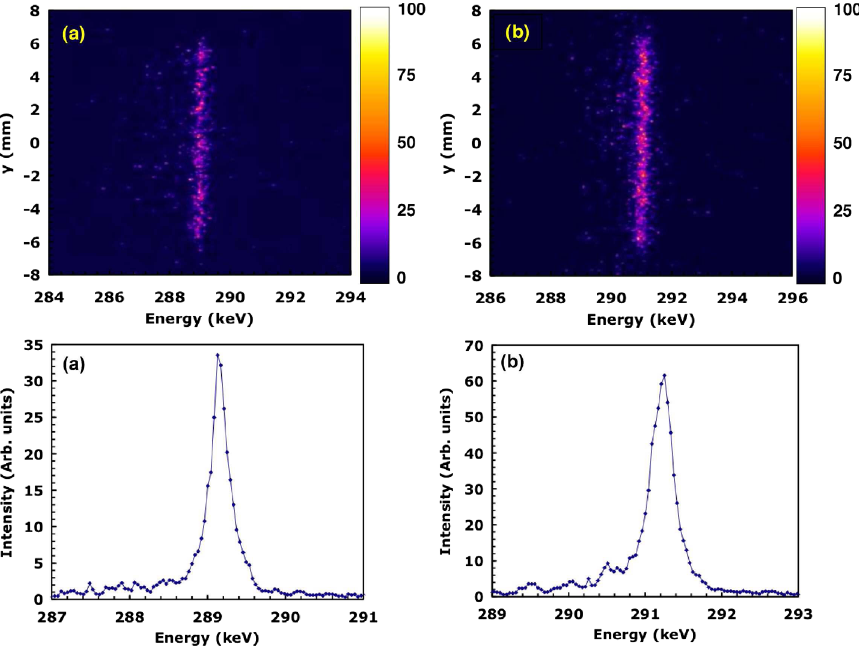
FIG. 6. Top row: Transverse slices of the beam integrated over a 500 ns gate in the middle of a 3 (cid:1) s pulse. Bottom row: Intensity of the transverse slices projected onto the energy axis for: (a) an unneutralized beam; and (b) a beam neutralized by the FEPS (note scale differences).